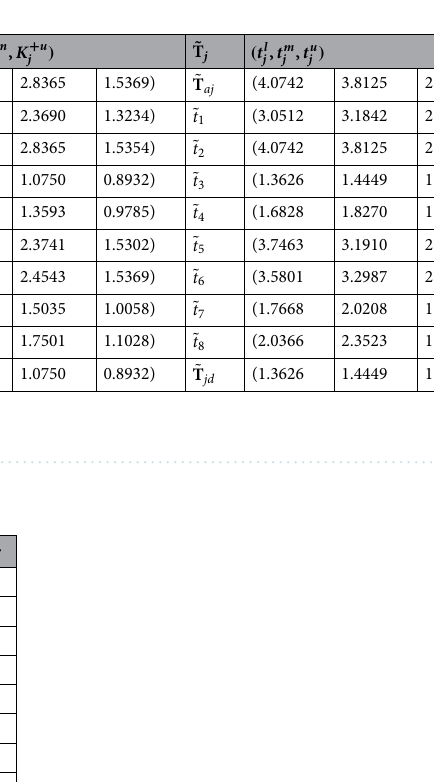
Table 9. Obtained